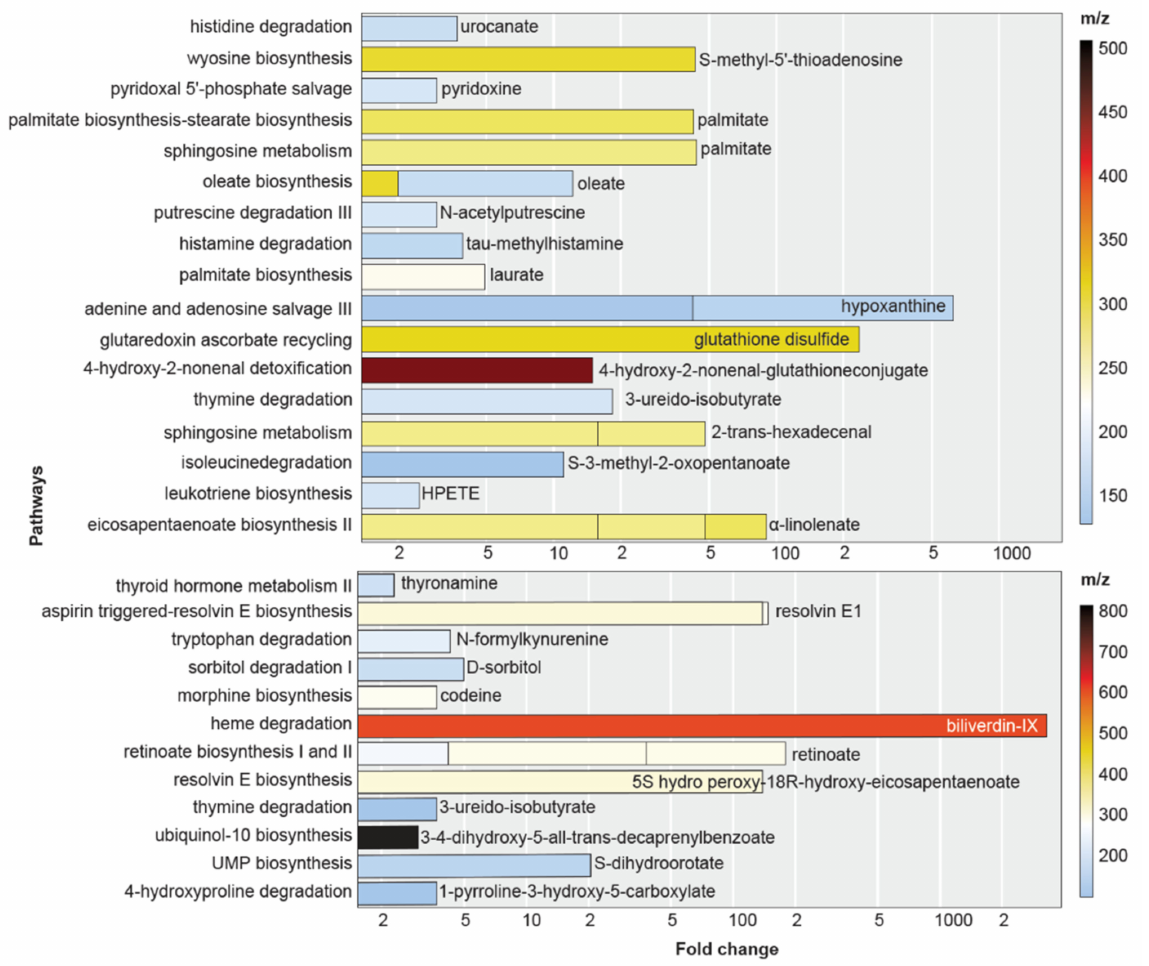
Figure 2. Up (top) and down (bottom)-regulated metabolic pathways in pellet fractions from safranal-treated HCC cells as predicted from the HPLC–MS results in the Systems Biology module of XCMS [17]. These pathways were based on metabolic pathways annotated in the BioCyc4 (biocyc.org) and Uniprot6 (uniprot.org) databases. Their respective metabolites, degree fold-change ( x -axis), and mass-to-charge ratios ( m / z , heatmap) are shown. Dysregulated metabolites are indicated inside or adjacent to bars for increased (top) or decreased (below) metabolites in safranal-treated cells. Multiple adducts for the same compound are shown as stacked